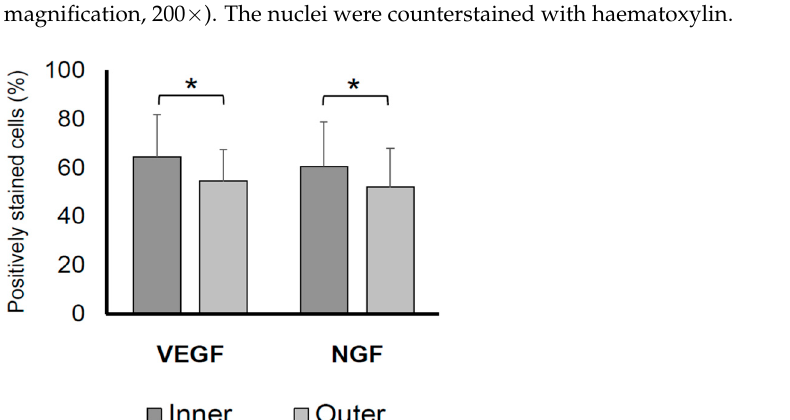
Figure 2. Percentages of VEGF- and NGF-positive cells on the inner and outer acetabular labral surfaces. The VEGF- and NGF-positive stained cell rate in the labral inner region was significantly higher than that in the labral outer region ( p < 0.05). * p < 0.05. NGF, nerve growth factor; VEGF, vascular endothelial growth factor.